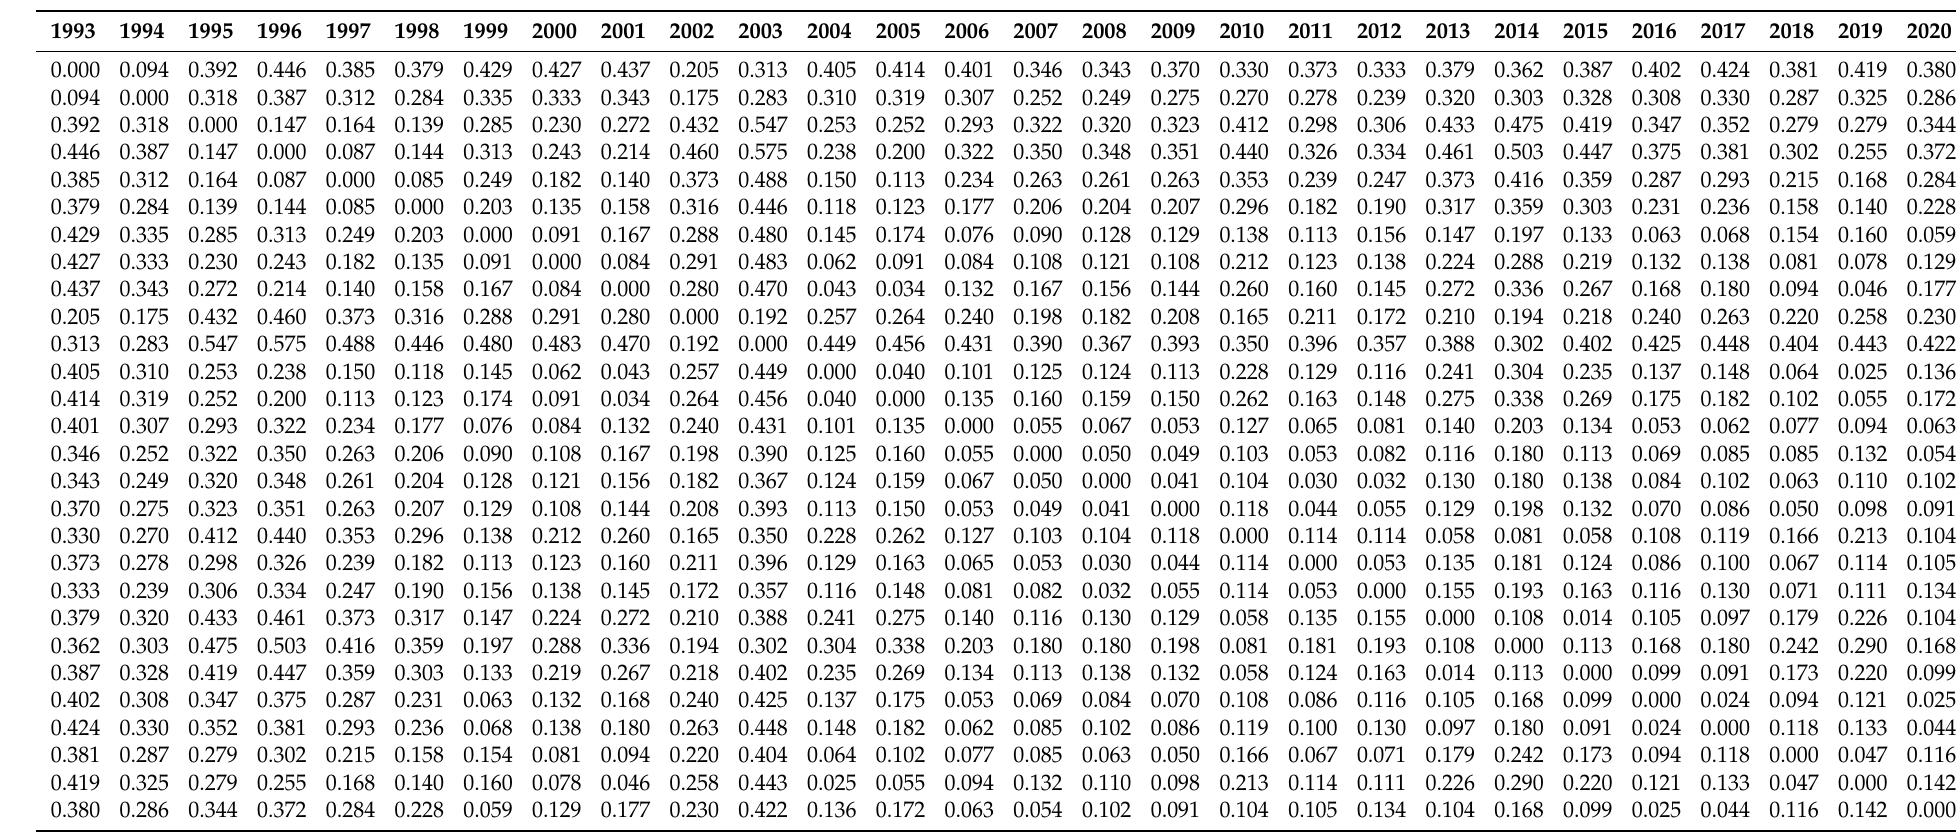
Table A2. Intensity of changes in the structure (NPS) of investment outlays in mining enterprises in Poland in